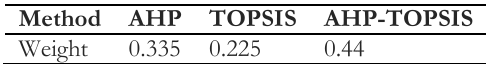
Table 10. The weights of three methods AHP, TOPSIS and AHP-TOPSIS.